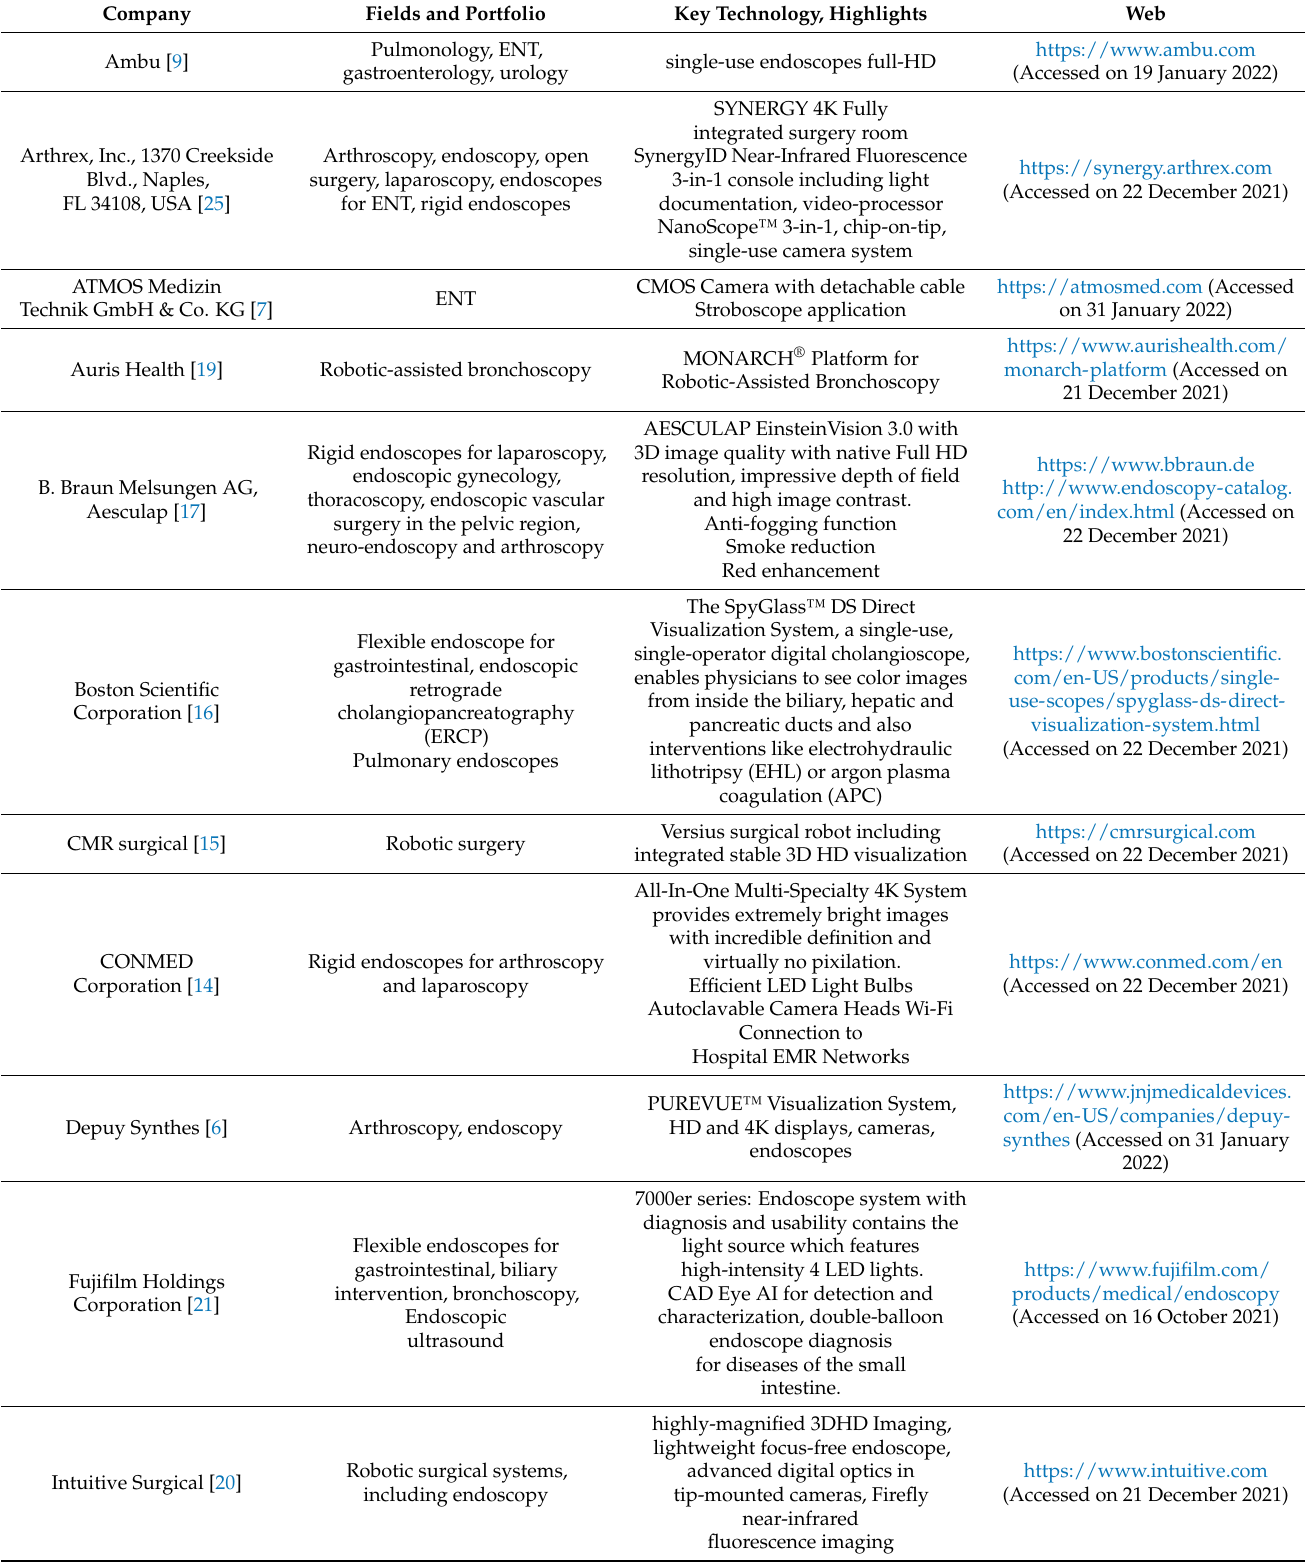
Table 1. Endoscopy systems providers (alphabetic order) and their fields of